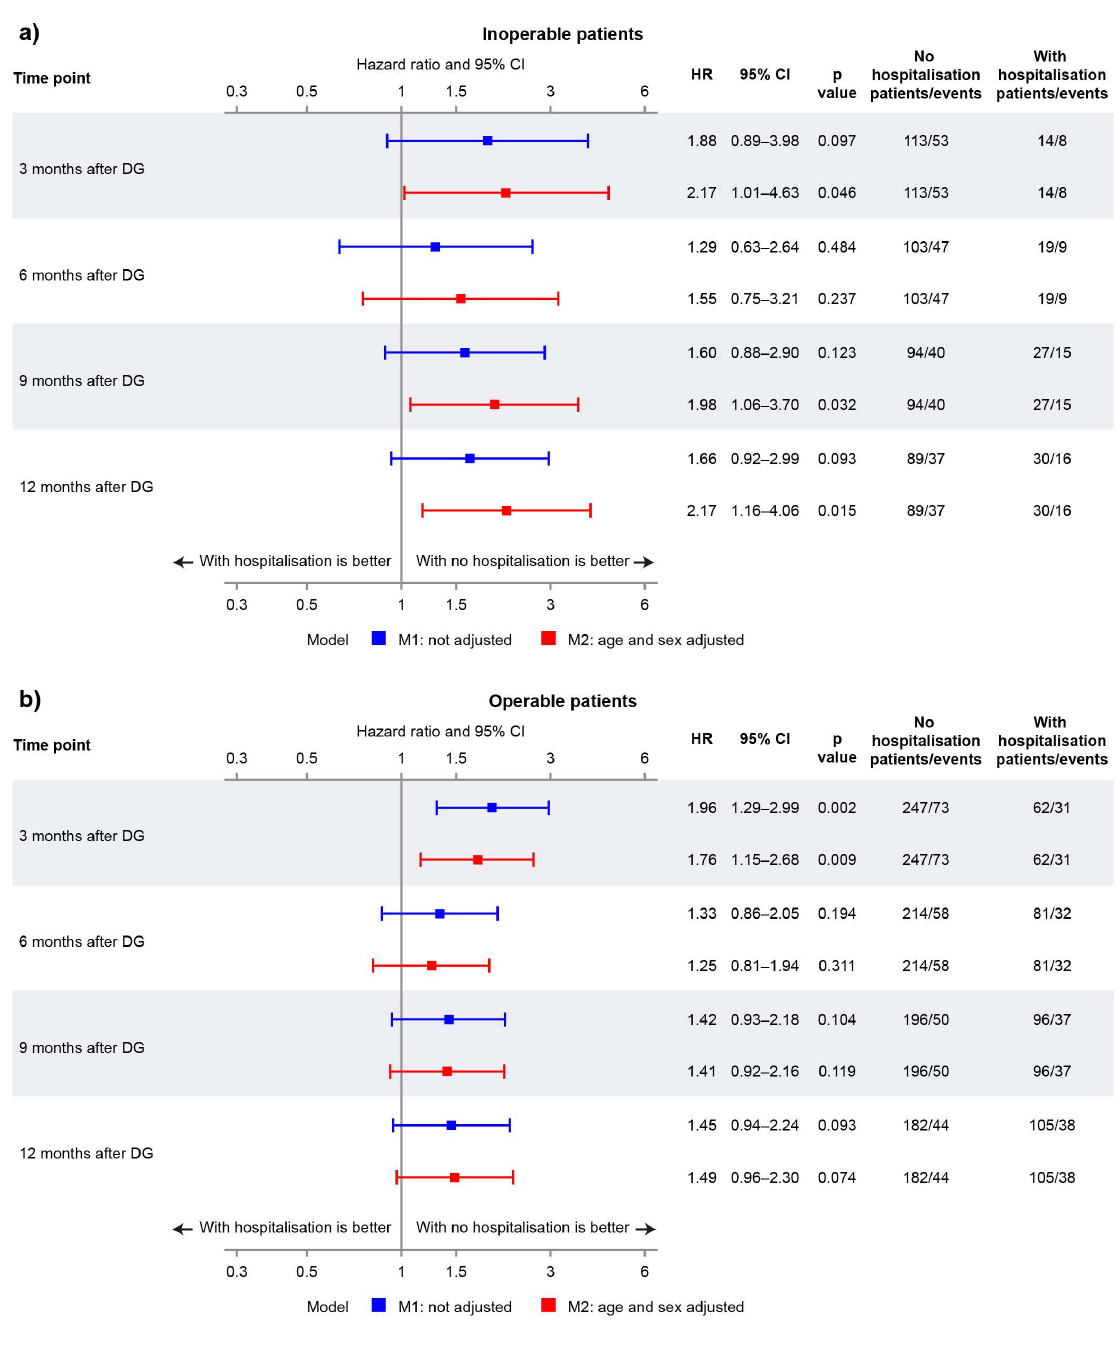
Figure 3. Forest plot showing hazard ratios (HRs) for non-adjusted and adjusted models at landmark timepoints for ( a ) inoperable patients and ( b ) operable